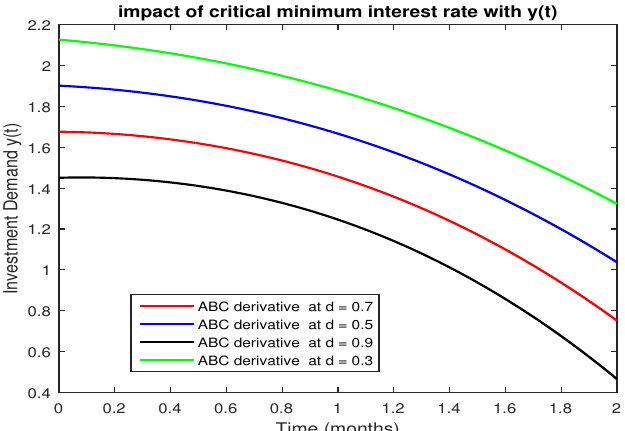
Figure 12. Impact of critical minimum interest rate with y ( t )